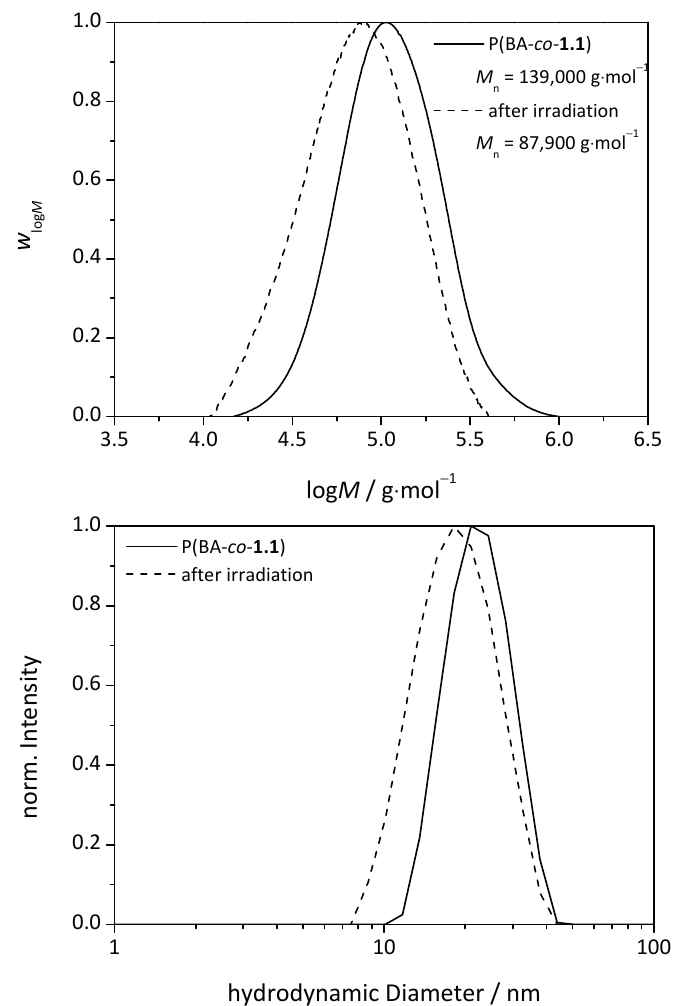
Figure 11. SEC-traces (THF) ( top ) of star (BA- co - 1.1 ) sample from the polymerization of c BA = 4882 mmol·L − 1 , c AIBN = 0.96 mmol·L − 1 , c RAFT = 0.58 mmol·L − 1 , and c in toluene at 60 °C for 115 min, and the corresponding size distribution ( bottom ) before (solid line) and after UV-crosslinking (dashed line) for 30 min using a UV mercury-vapor lamp of 100 W in THF:methanol